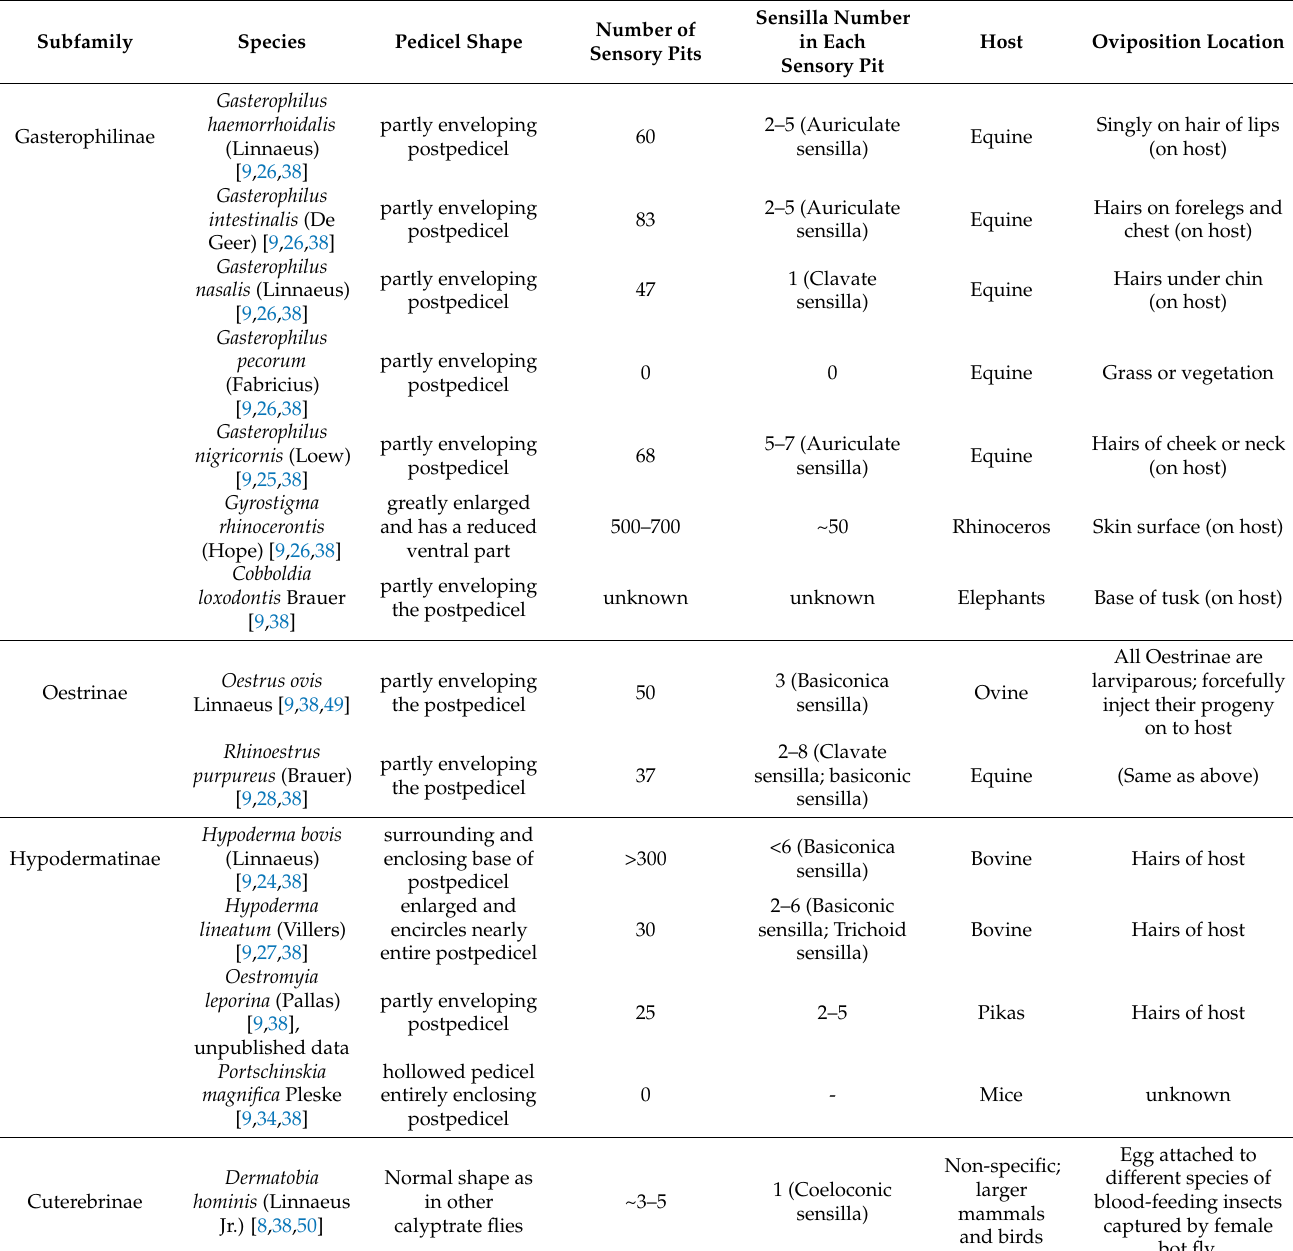
Table 2. Comparison of biology, antennal morphology, and antennal ultrastructure in Oestridae. (The data in this table refer to the literature cited after the species